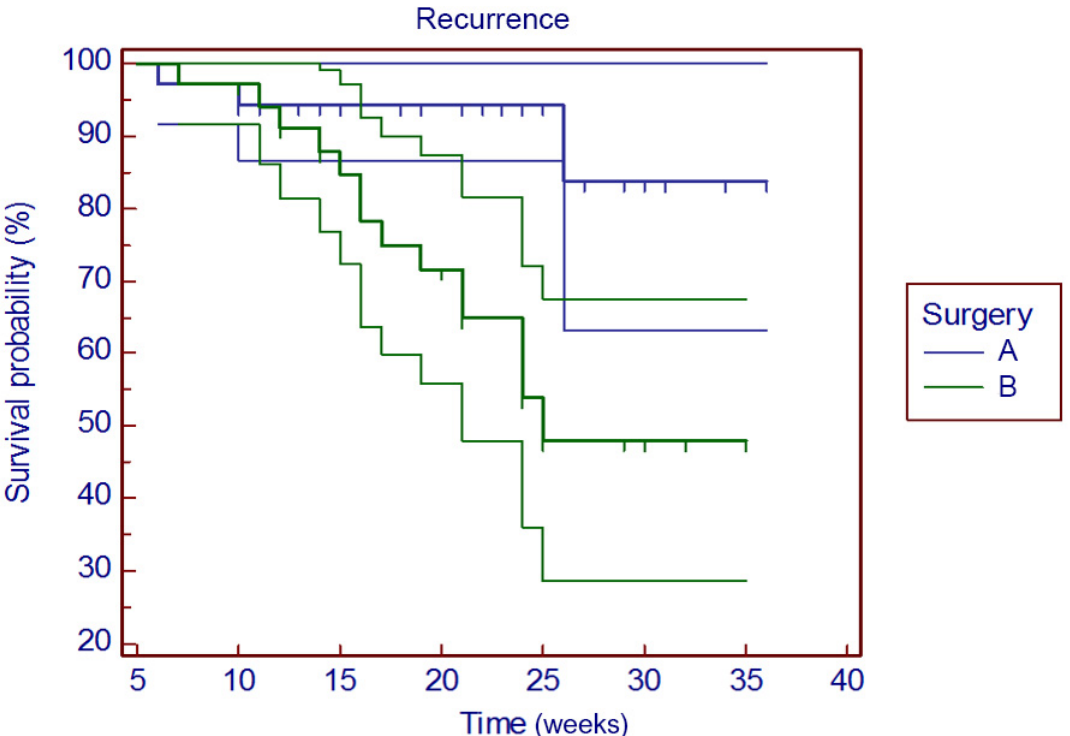
Figure 6. Kaplan–Meier curve analyzes recurrence risk of group A and B.